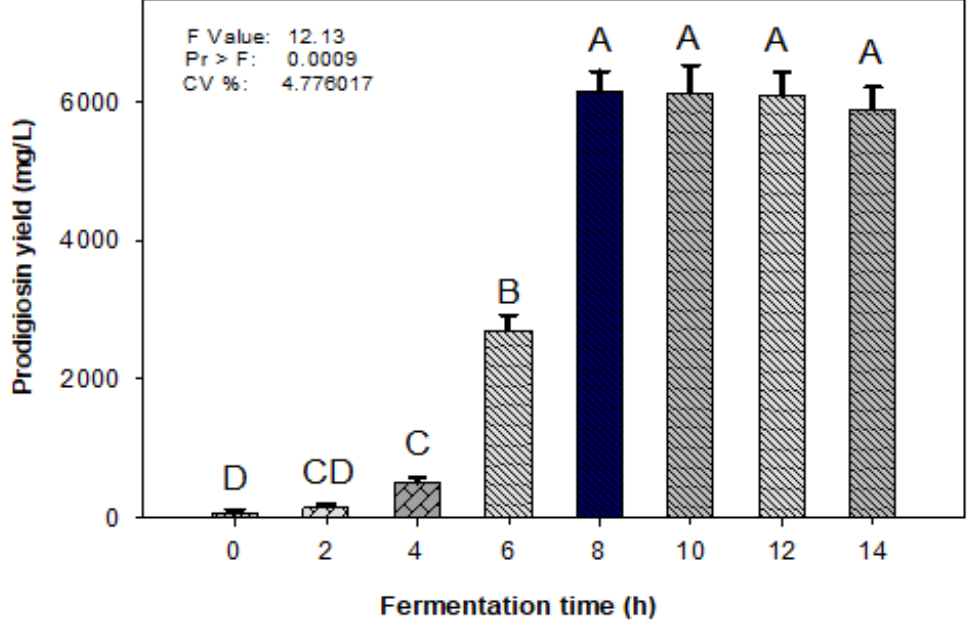
Figure 3. Bioconversion of medium based on cassava waste to prodigiosin in a 14 L-bioreactor. All experiments were conducted in triplicate. The data were analyzed via the simple variance (ANOVA), then Duncan′s multiple range test was performed at p = 0.01. Means of prodigiosin yield values with the same letter in each figure are not significantly different. Standard errors (SD) are shown as error bars .